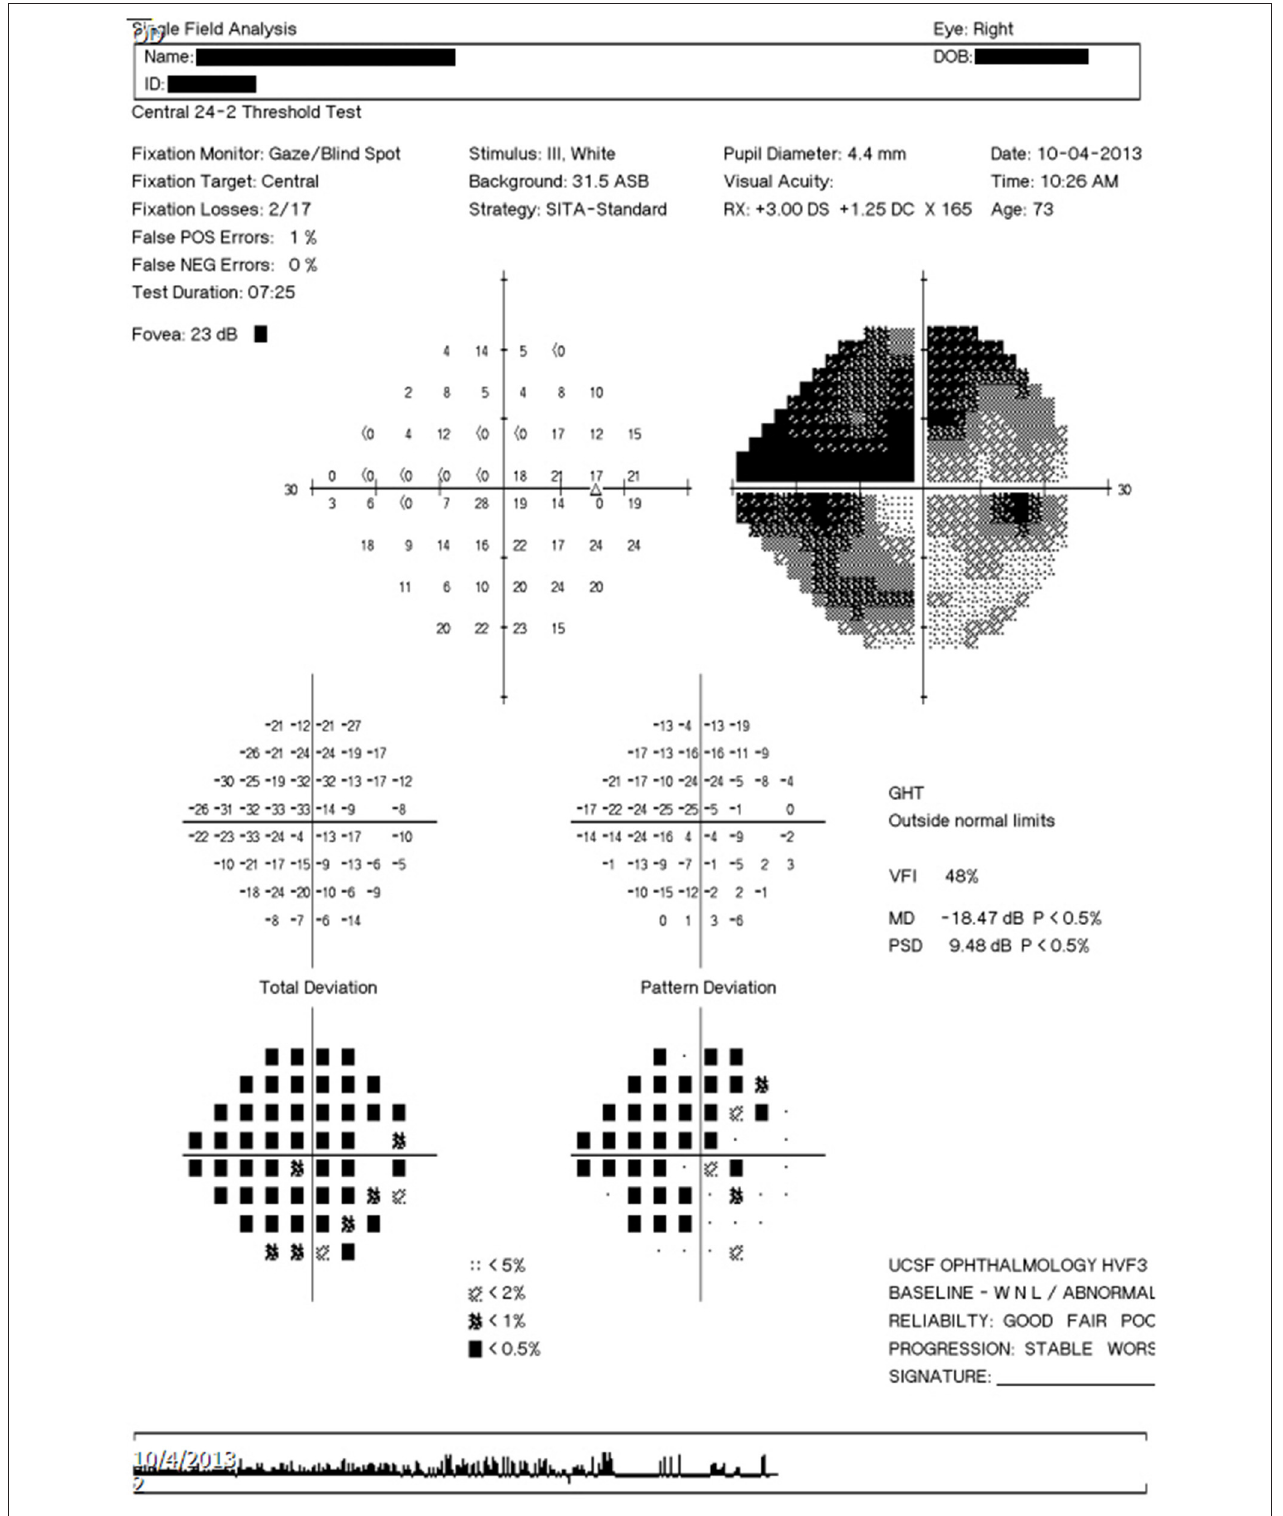
FIGURE 2 | Example output text file. Example output text file corresponding to the image report seen in Figure 3C .